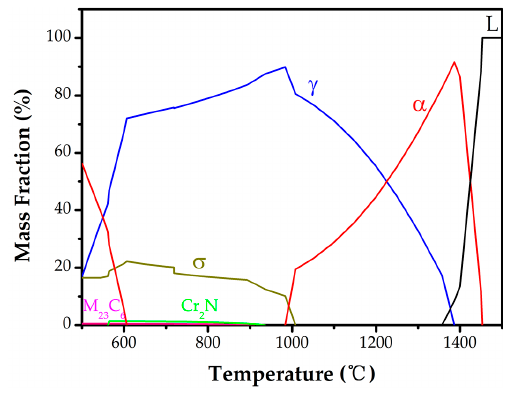
Figure 4. The equilibrium phase transition diagram.